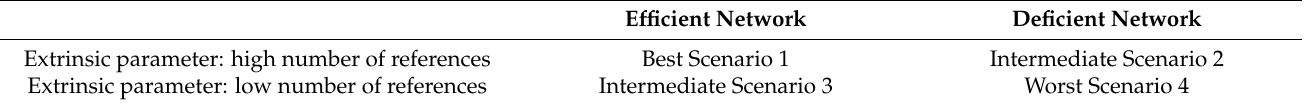
Table 1. Results expected for the measurements of the reference wall from the four scenarios